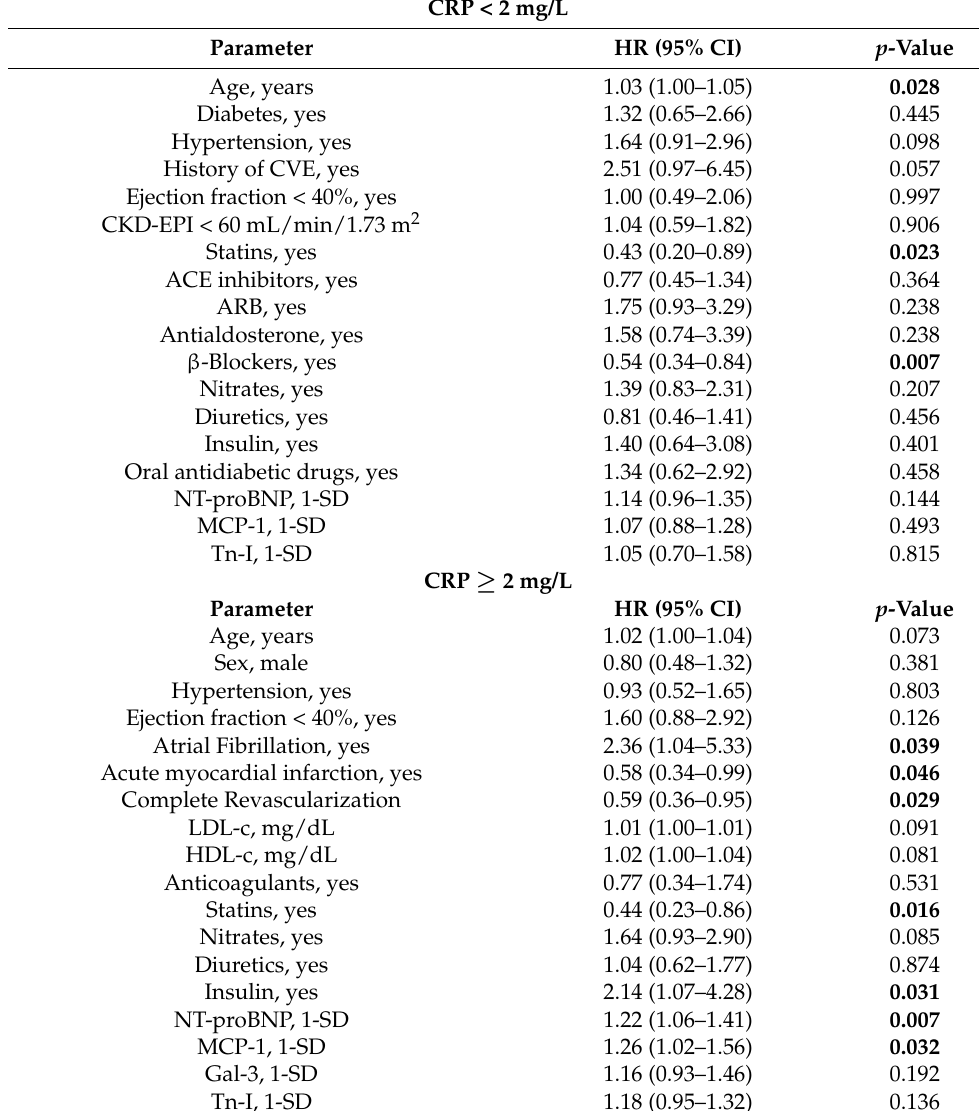
Table 2. Multivariate Cox proportional hazard model for the incidence rates of acute ischemic events, heart failure and